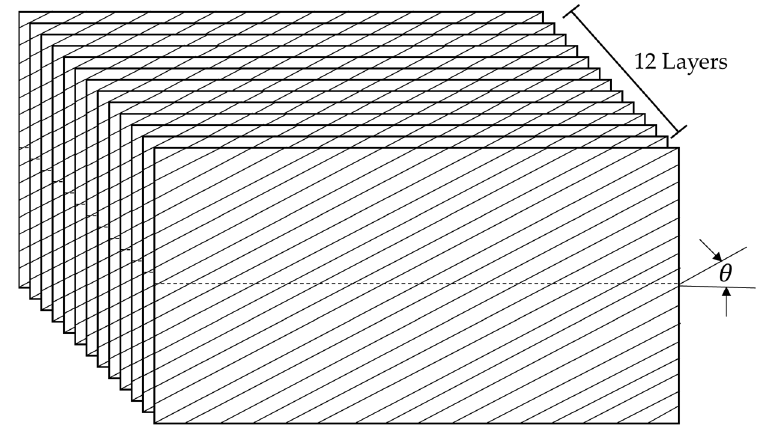
Figure 1. Carbon fiber angle in the multi-layered CFRP specimen.